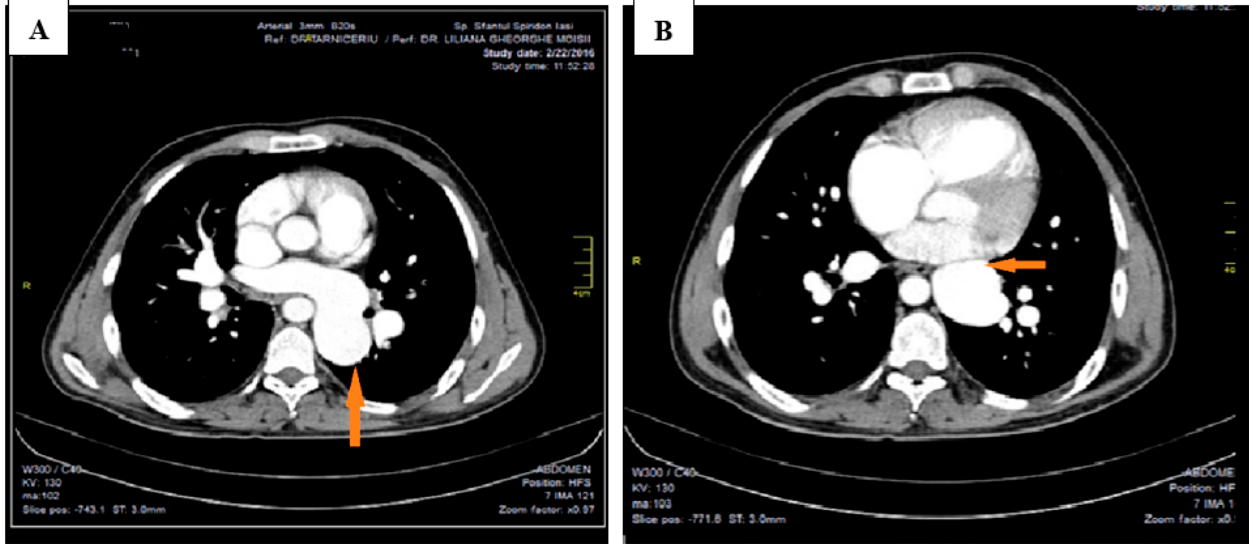
Figure 1. Thoracic CAT scan: ( A )—a vertical collecting canal located in the left side of the mediastinum that opens into the left brachiocephalic vein. Arrow shows the presence of a vertical collecting canal.; ( B )—not noted connection (opening) between the collecting canal and the left atrium. Arrow shows the relation of a vertical collecting canal with left atrium.